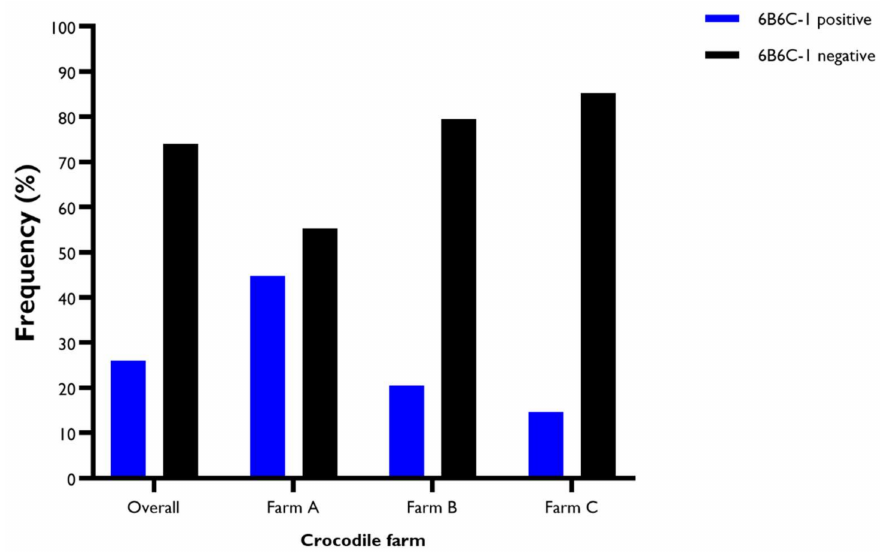
Figure 1. Sero-prevalence of flavivirus antibodies in farmed crocodiles based on blocking ELISA using the flavivirus envelope protein-specific mAb, 6B6C-1. Positive samples are blue bars, and negative samples are black